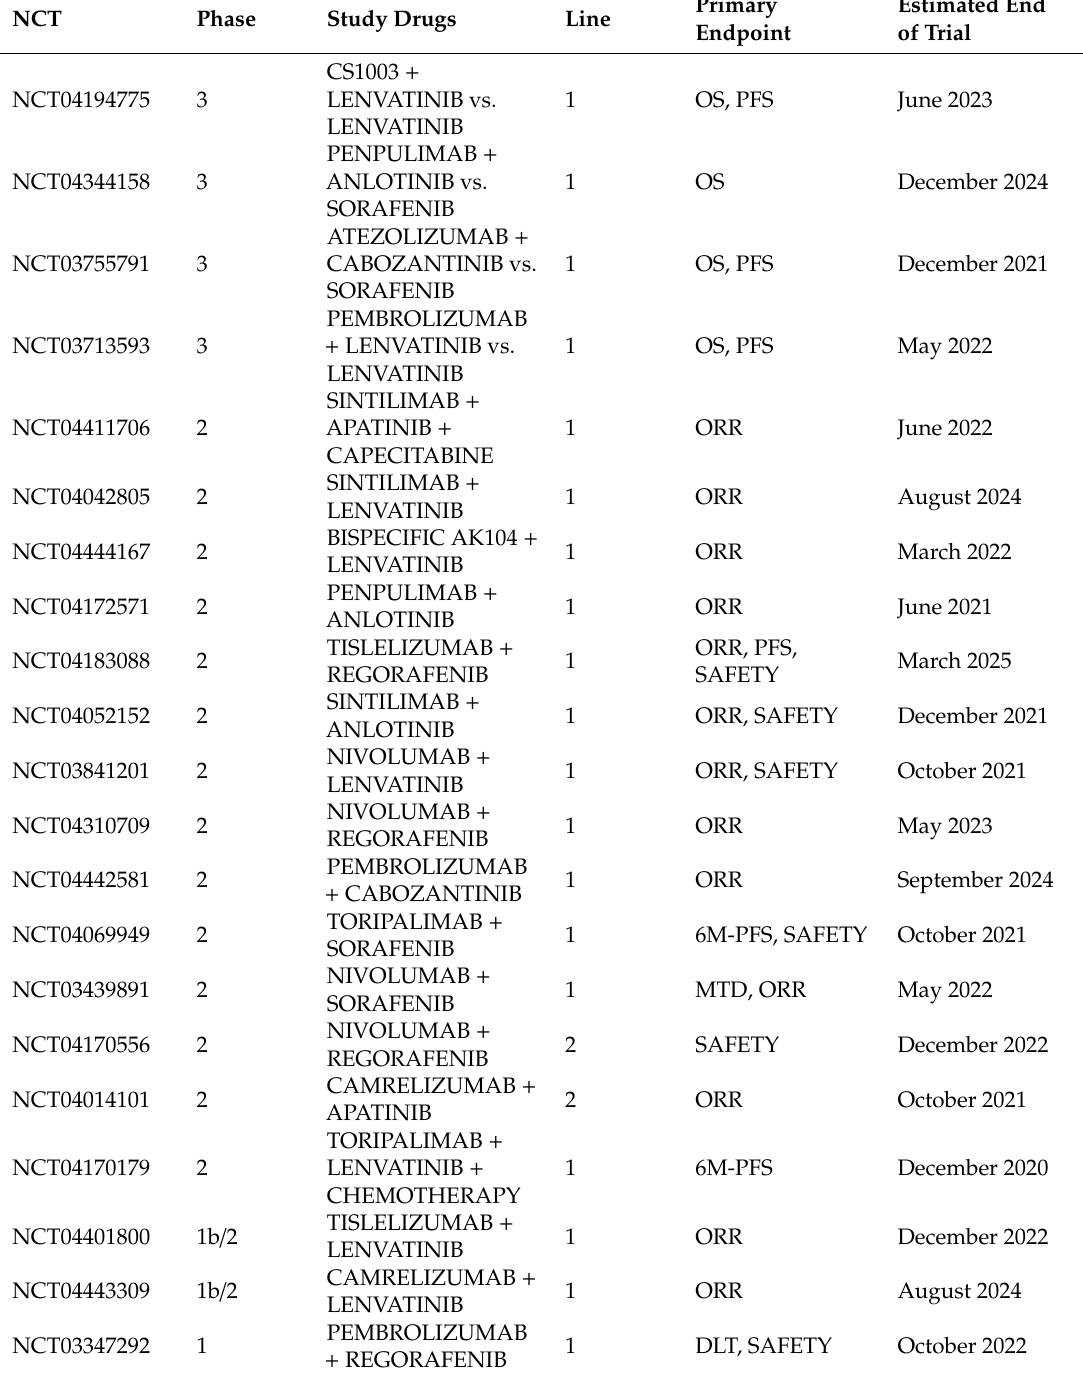
Table 2. Ongoing clinical trials that explore the combination of PD1 inhibitors and oral tyrosine kinase inhibitors as a treatment for advanced hepatocellular